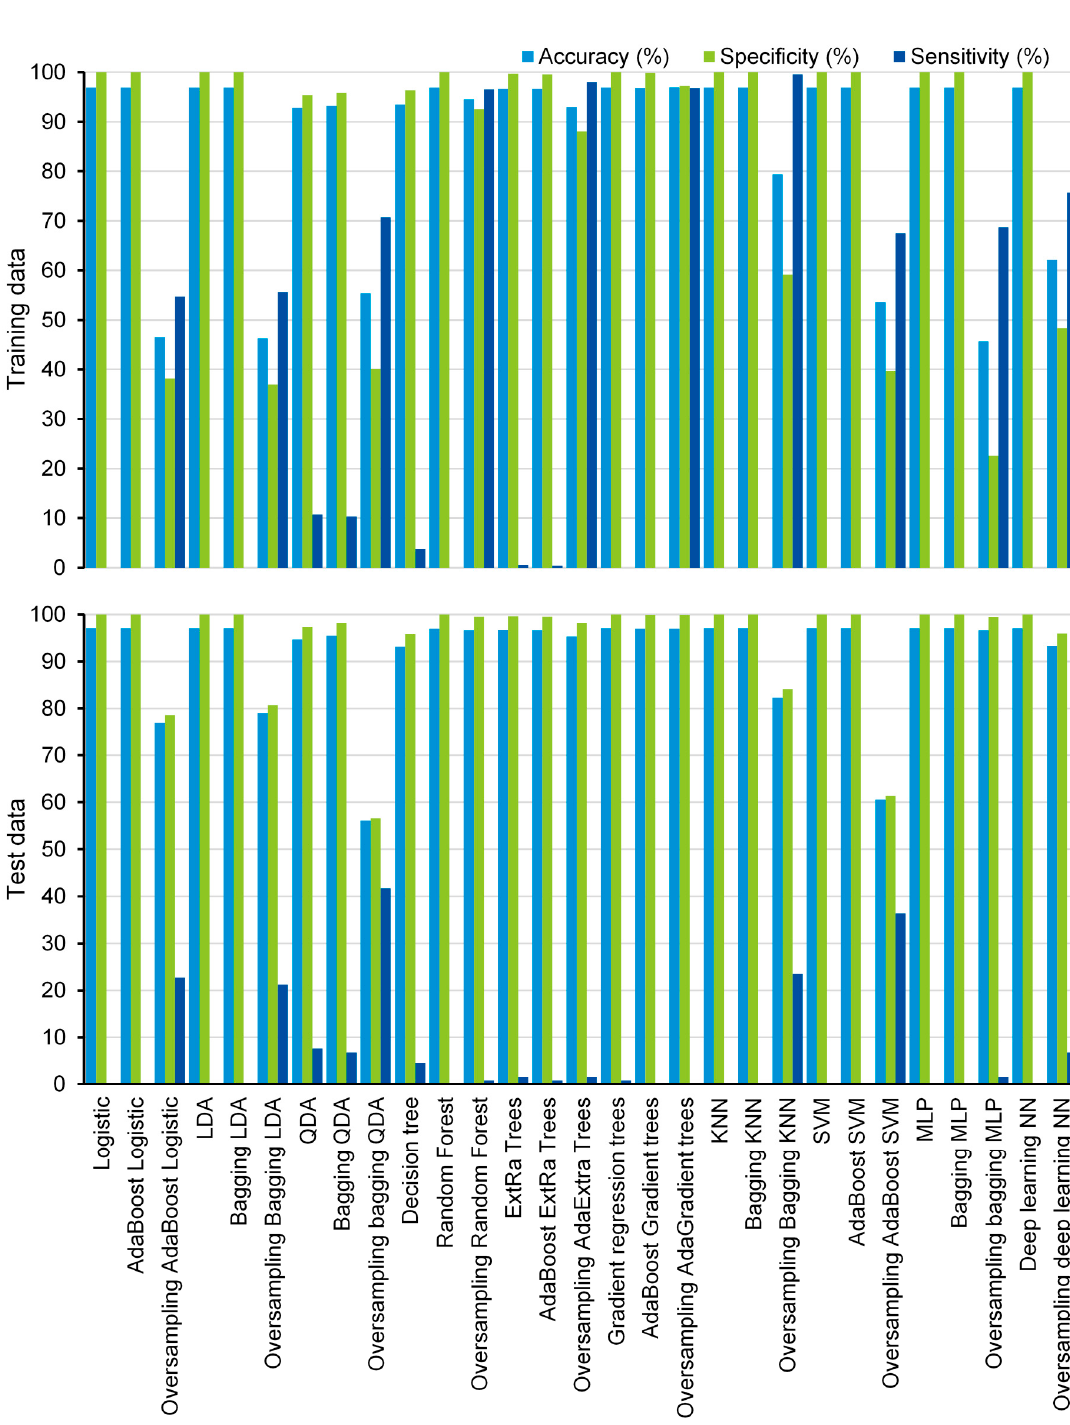
Figure 1. Performance of the algorithms. AdaBoost—adaptive boosting; LDA—linear discriminant analysis; QDA—quadratic discriminant analysis; ExtRa—extremely randomized; AdaExtra—adaptive boosting extremely randomized; AdaGradient—adaptive boosting gradient; KNN—k-nearest neighbor; SVM—support vector machine; MLP—multilayer perceptron; NN—neural network.